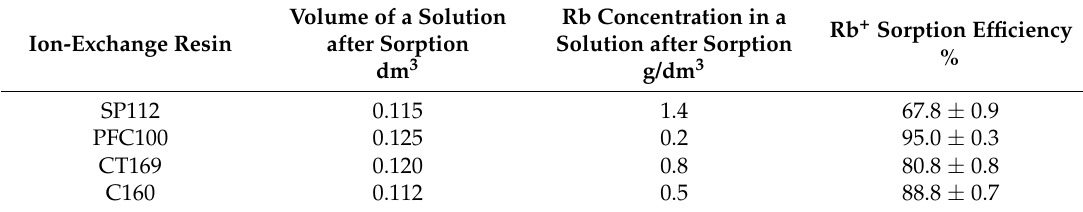
Table 2. Results of ion-exchange resin selection for rubidium sorption.